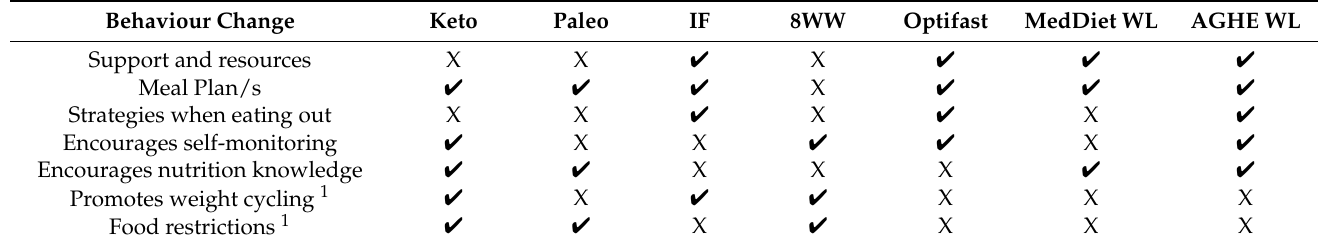
Table 2. Contribution to behaviour change category and long-term sustainability of popular weight loss diets and healthy eating